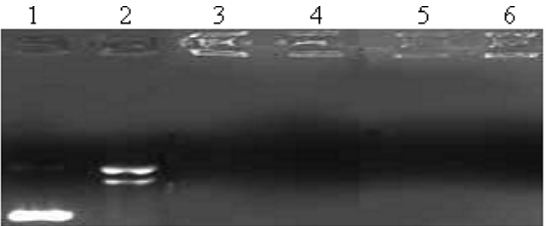
Figure 3 . Effect of different ligands and complexes on the interaction with pUC19 DNA (7 m g/ml) with the existence of DNaseI in a Tris-HCl buffer (100 mM, pH 7.4) at 37 ºC for 0.5 h. Agarose gel electrophoresis diagram: lane 1, DNA control ; lane 2 DNA+ DNaseI; lane 3 DNA+ DNaseI + 6a ; lane 4 DNA + DNaseI + 6b ; lane 5 DNA + DNaseI +1a ; lane 6 DNA+ DNaseI + 1b . A typical imidazoluim 1-ethyl-3-methylimidazolium bromide (EMI) can not bind DNA, as